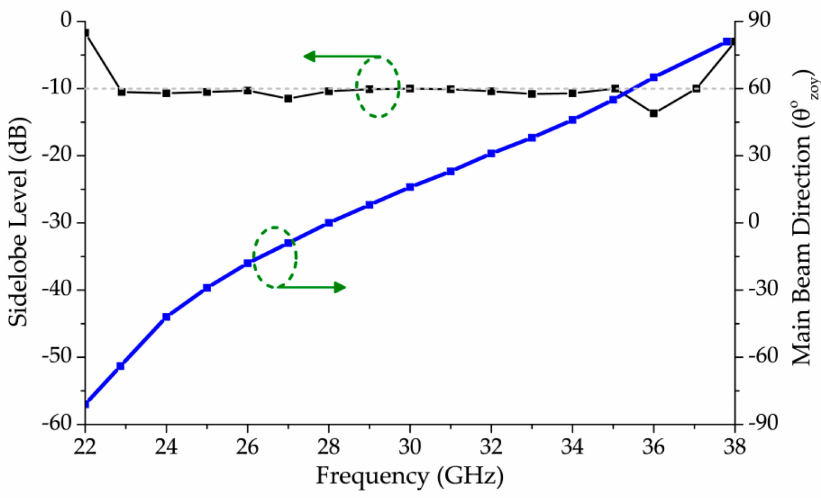
Figure 12. Sidelobe level and main beam direction in the yz-plane of the proposed